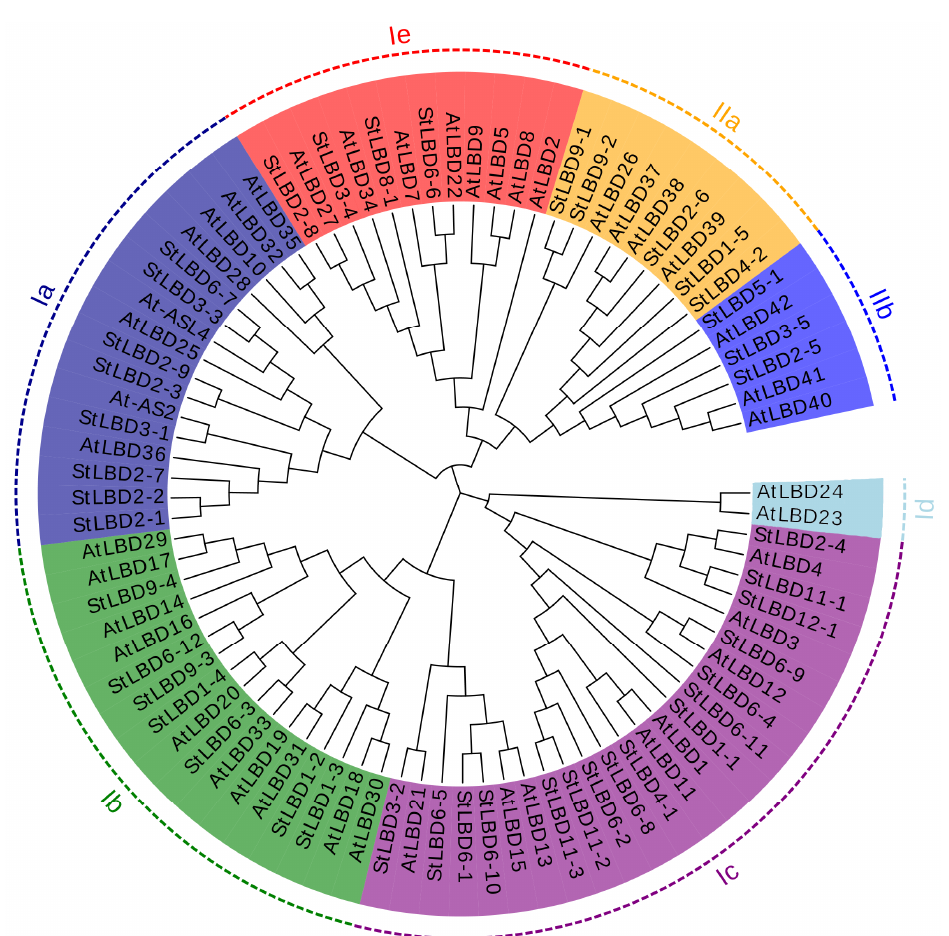
Figure 2. The phylogenetic tree of LBD transcription factors of potato and Arabidopsis . The clustering analysis is based on 1000 replications for increasing the credibility of the bootstrap value.